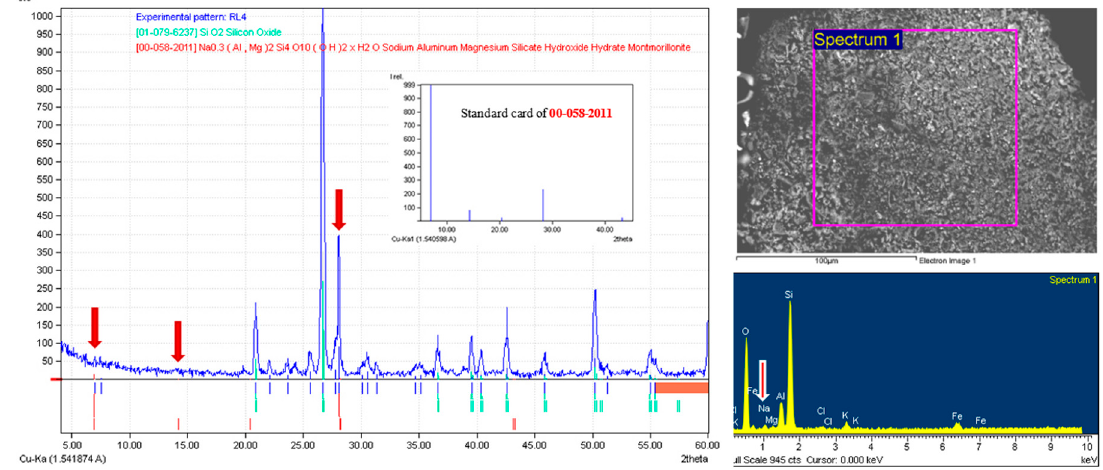
Figure 7. Result of XRD and EDS experiments for R15.